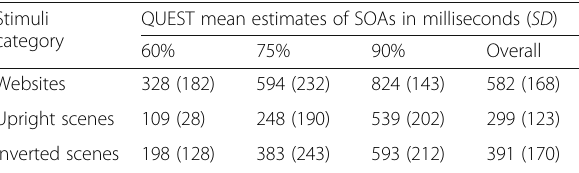
Table 2 Mean SOAs for each collapsed stimulus type across accuracy thresholds